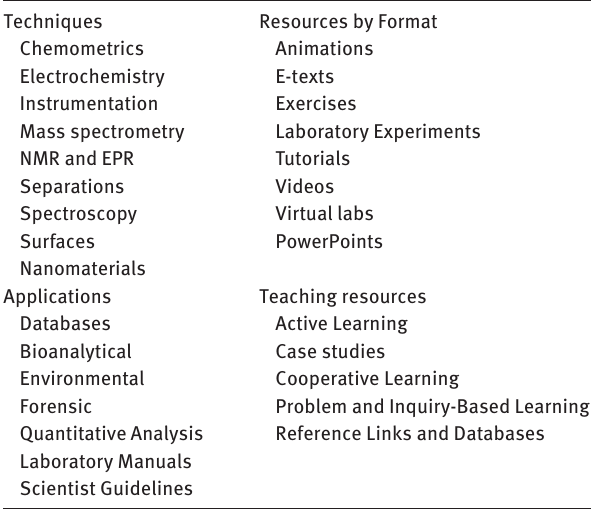
Table 1 Four major headings and additional subtopics in the ASDL